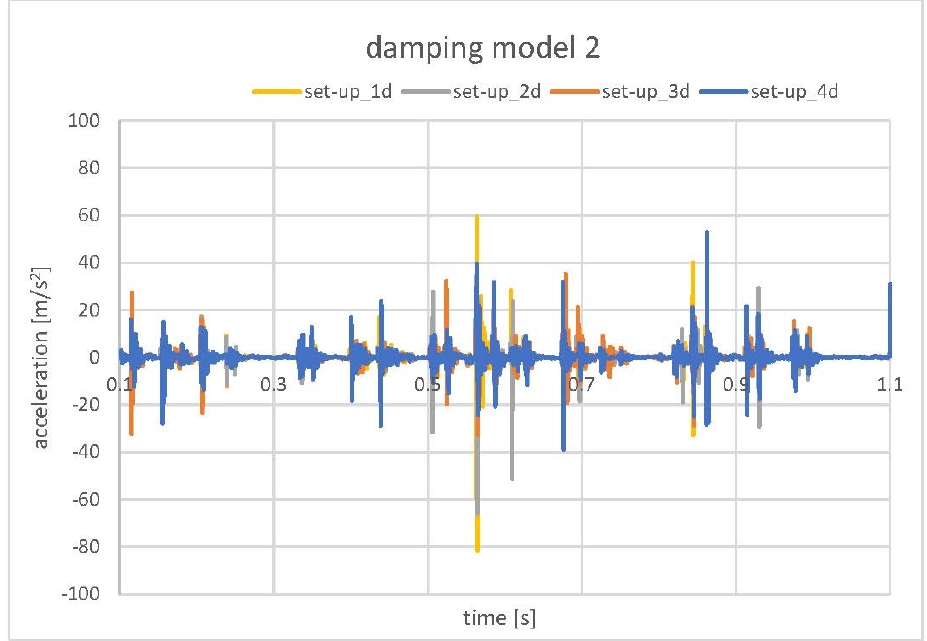
Figure 16. Model sensitivity analysis. Contact damping model 2–CRB accelerations.